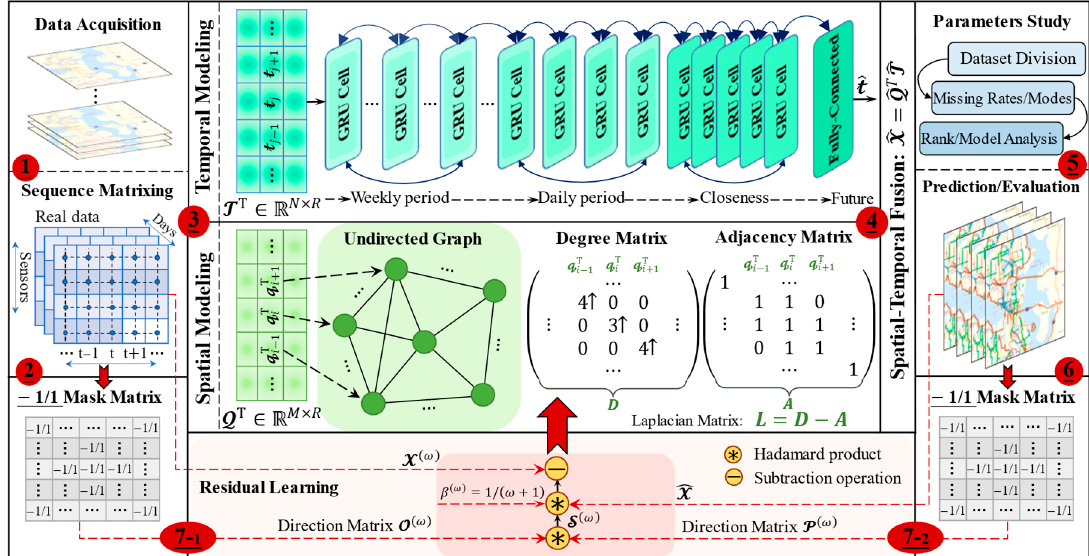
Figure 2. Schematic of the spatial-temporal matrix factorization (white boxes denote missing data).